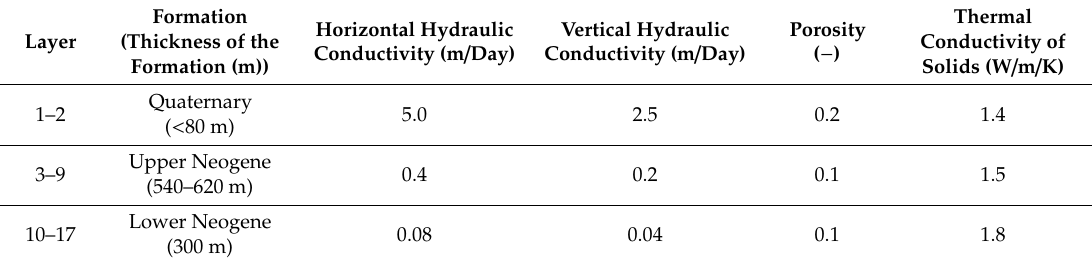
Figure 1. Study area and modeled area quoted from Kaneko et al. [21]. The relief map and elevation data are drawn using the 10 m grid digital elevation map sourced from the Geospatial Information Authority of Japan (GSI). Table 1. Input parameters of the regional model of the Sendai Plain quoted from Kaneko et al.